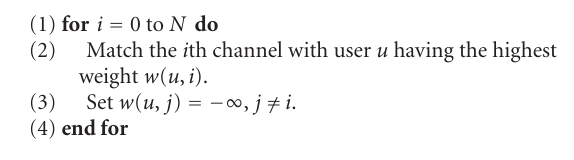
Algorithm 2: Greedy matching.